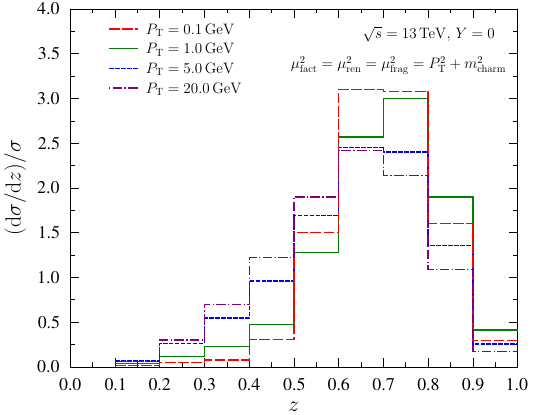
p s = 13 TeV and Y = 0 for four (cid:12)xed values of P T .